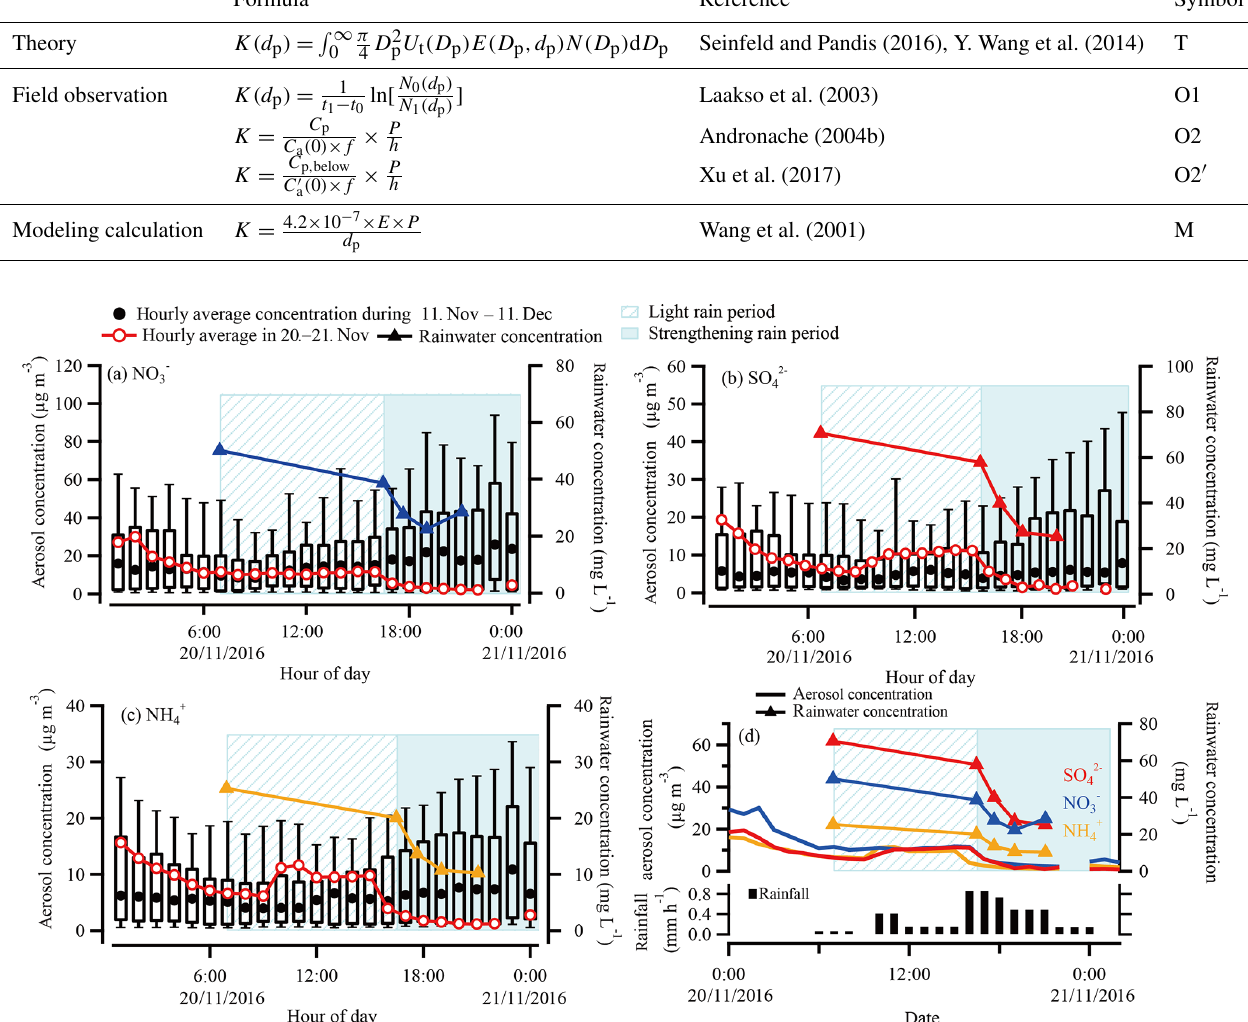
Figure 1. Hourly average aerosol concentration from 11 November to 11 December (box and whisker plots; the data show the lowest value, 25th percentile, median highest quartile, 75th percentile and highest value, respectively) and the rainy period on 20 to 21 November (red line and hollow circles) for (a) NO − , (b) SO 2 − and (c) NH + . The rainwater concentrations are shown as follows: (a) NO − , blue; (b) SO 2 − , red; 3 4 4 3 4 and (c) NH + , orange (line and triangles). Time series of the NO − (blue), SO 2 − (red) and NH + (orange) concentrations in the rainfall (lines 4 3 4 4 and triangles) and in the air (lines) and rainfall (d)